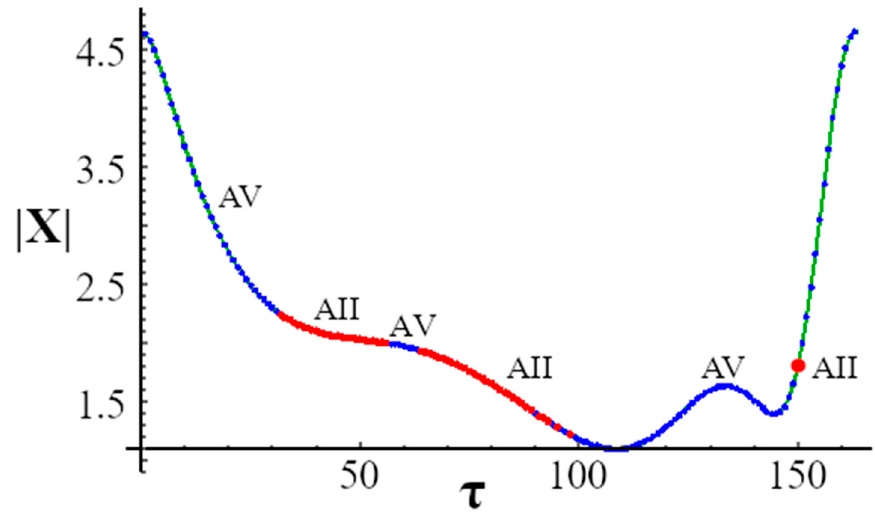
Figure 11. Power-shift method applying a linear ramp with T lag = 15 and noise with amplitude = ±0.0015 , Y 0 = 1.63 for base AIII with the Y PS = 1.84 .